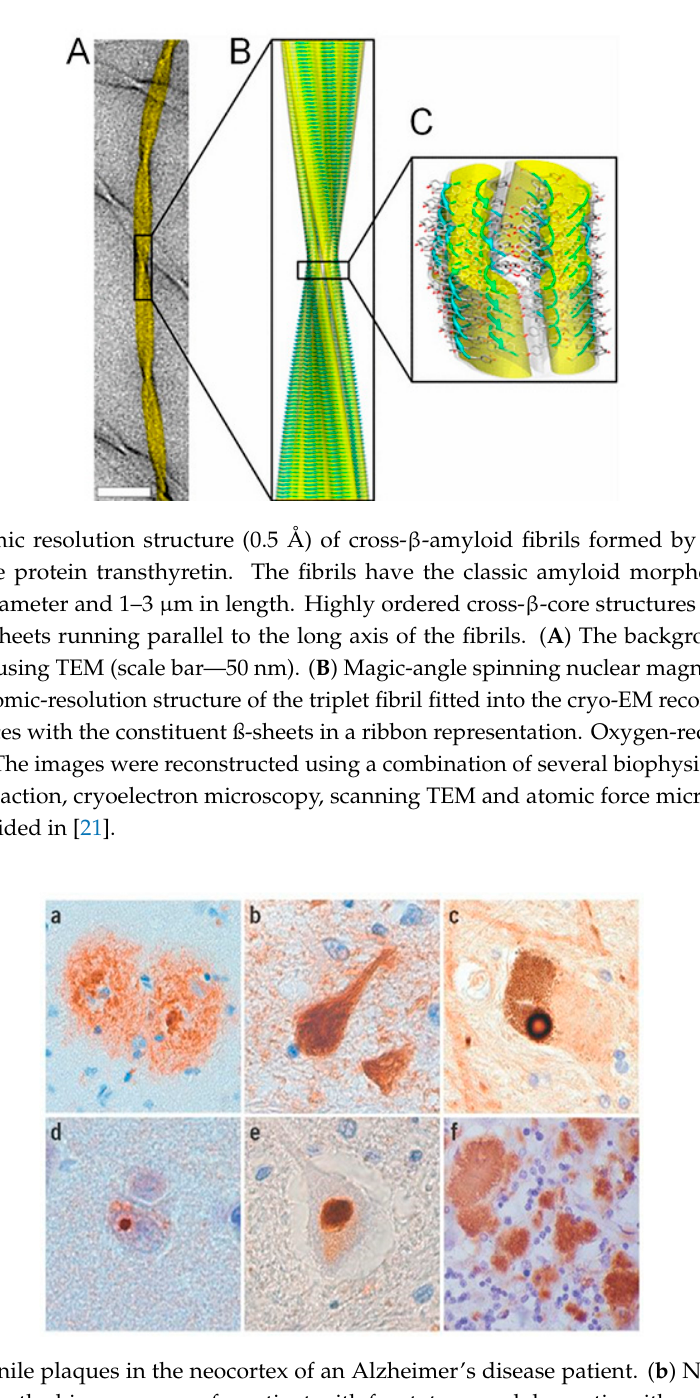
Figure 4. ( a ) Senile plaques in the neocortex of an Alzheimer’s disease patient. ( b ) Neuro-fibrillary tangles (NFTs) in the hippocampus of a patient with frontotemporal dementia with parkinsonism-17 (FTDP-17) (R406W mutation). ( c ) Lewy body in the substantia nigra of a Parkinson’s disease patient ( d ) Intranuclear polyglutamine inclusion in the neocortex of a Huntington disease patient. ( e ) Ubiquitinylated inclusion in the spinal cord motor neuron of an amyotrophic latera; sclerosis (ALS) patient. ( f ) Protease-resistant prion protein (PrP) in the cerebellum of a frontotemporal dementia with parkinsonism-17 patient [23].